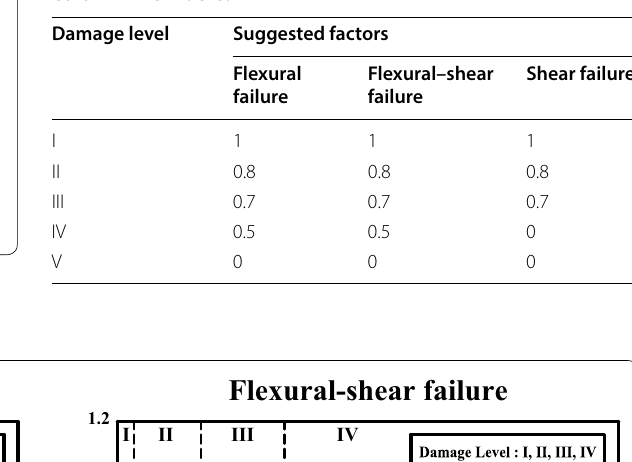
Table 11 Suggested reduction factors of stiffness for RC column